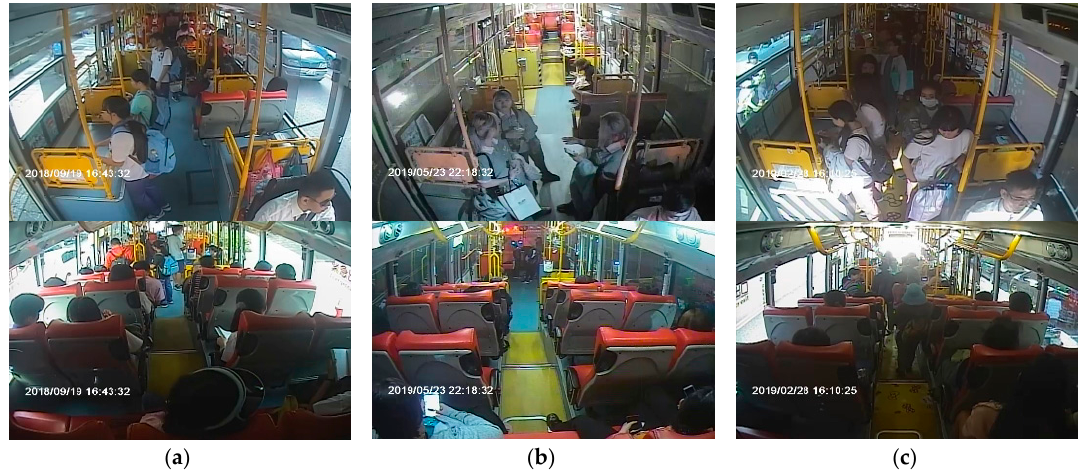
Figure 2. Positions of the surveillance cameras: ( a ) internal configuration of the bus—images of ( b ) front camera and ( c ) rear camera.